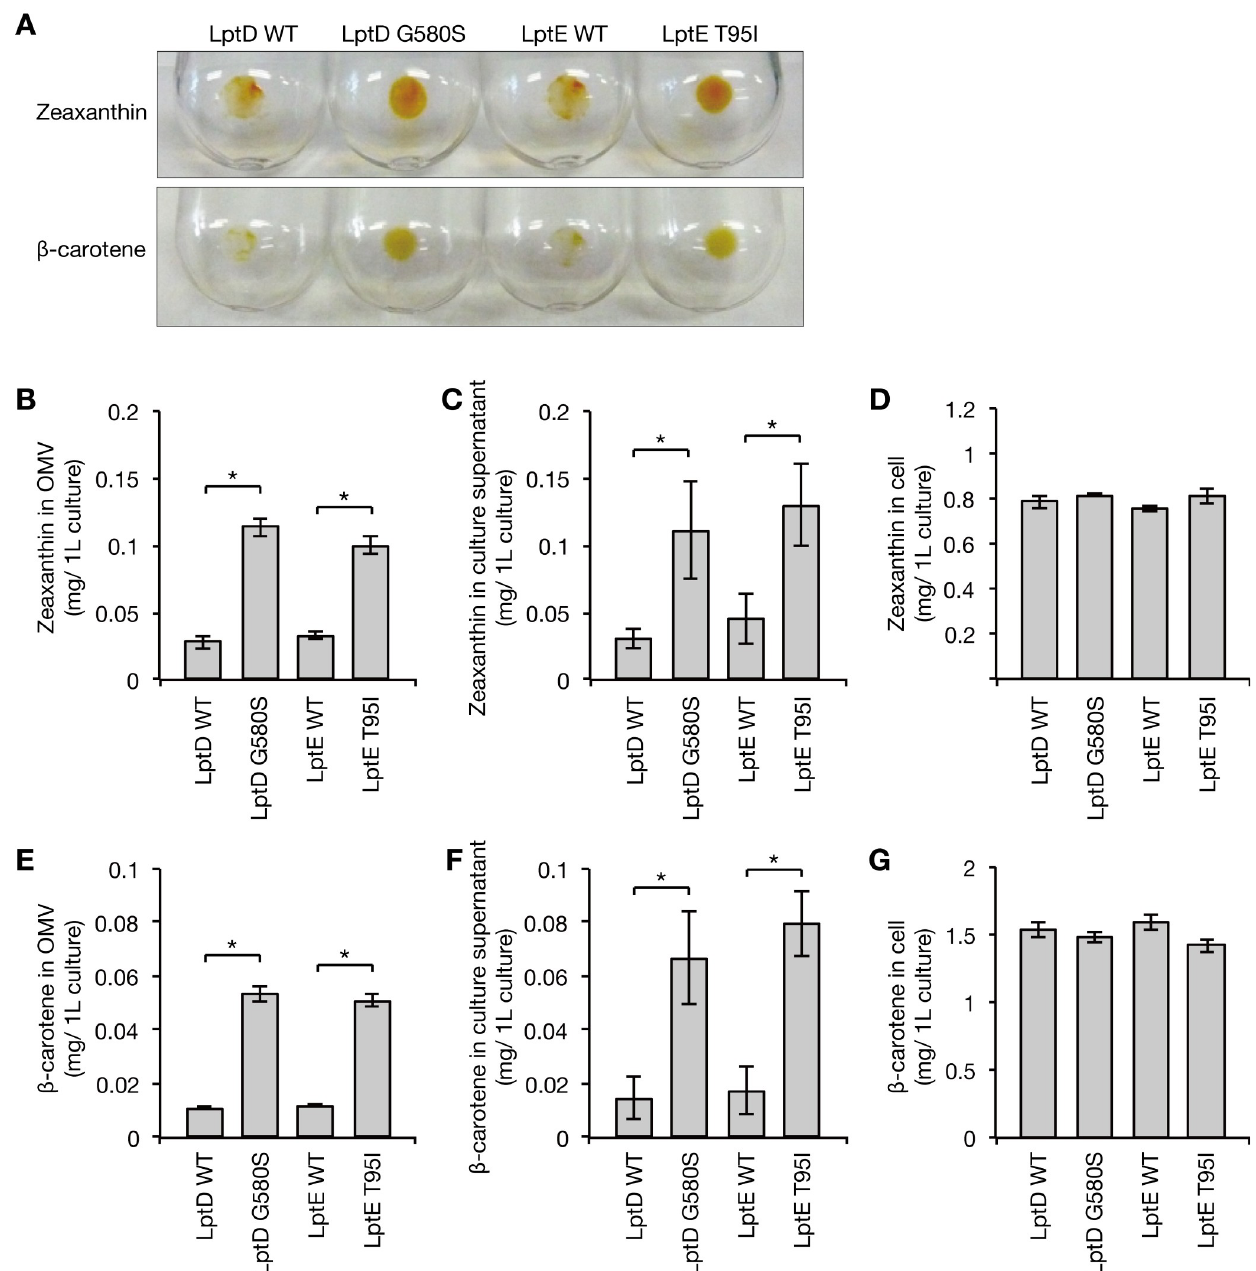
Fig 4. The LptD and LptE mutants extrude foreign chemicals together with OMVs. (A) The LptD WT, LptD G580S, LptE WT, and LptE T95I strains were transformed with plasmids to produce isoprenoids (zeaxanthin or β -carotene). The culture supernatants were ultracentrifuged for collection of OMVs. Images are the precipitates of ultracentrifugation. (B) The amounts of zeaxanthin in OMV fractions from the LptD WT, LptD G580S, LptE WT, and LptE T95I strains were measured. Data shown are means ± standard errors from three independent experiments. The asterisk represents a p value less than 0.05 (Student’s t test). (C) The amounts of zeaxanthin in the culture supernatants from the LptD WT, LptD G580S, LptE WT, and LptE T95I strains were measured. Data shown are means ± standard errors from three independent experiments. The asterisk represents a p value less than 0.05 (Student’s t test). (D) The amount of zeaxanthin in bacterial cells of the LptD WT, LptD G580S, LptE WT, and LptE T95I strains was measured. Data shown are means ± standard errors from three independent experiments. (E) The amount of β -carotene in OMV fractions from the LptD WT, LptD G580S, LptE WT, and LptE T95I strains was measured. Data shown are means ± standard errors from three independent experiments. The asterisk represents a p value less than 0.05 (Student’s t test). (F) The amounts of β -carotene in the culture supernatants from the LptD WT, LptD G580S, LptE WT, and LptE T95I strains were measured. Data shown are means ± standard errors from three independent experiments. The asterisk represents a p value less than 0.05 (Student’s t test). (G) The amount of β -carotene in bacterial cells of the LptD WT, LptD G580S, LptE WT, and LptE T95I strains was measured. Data shown are means ± standard errors from three independent